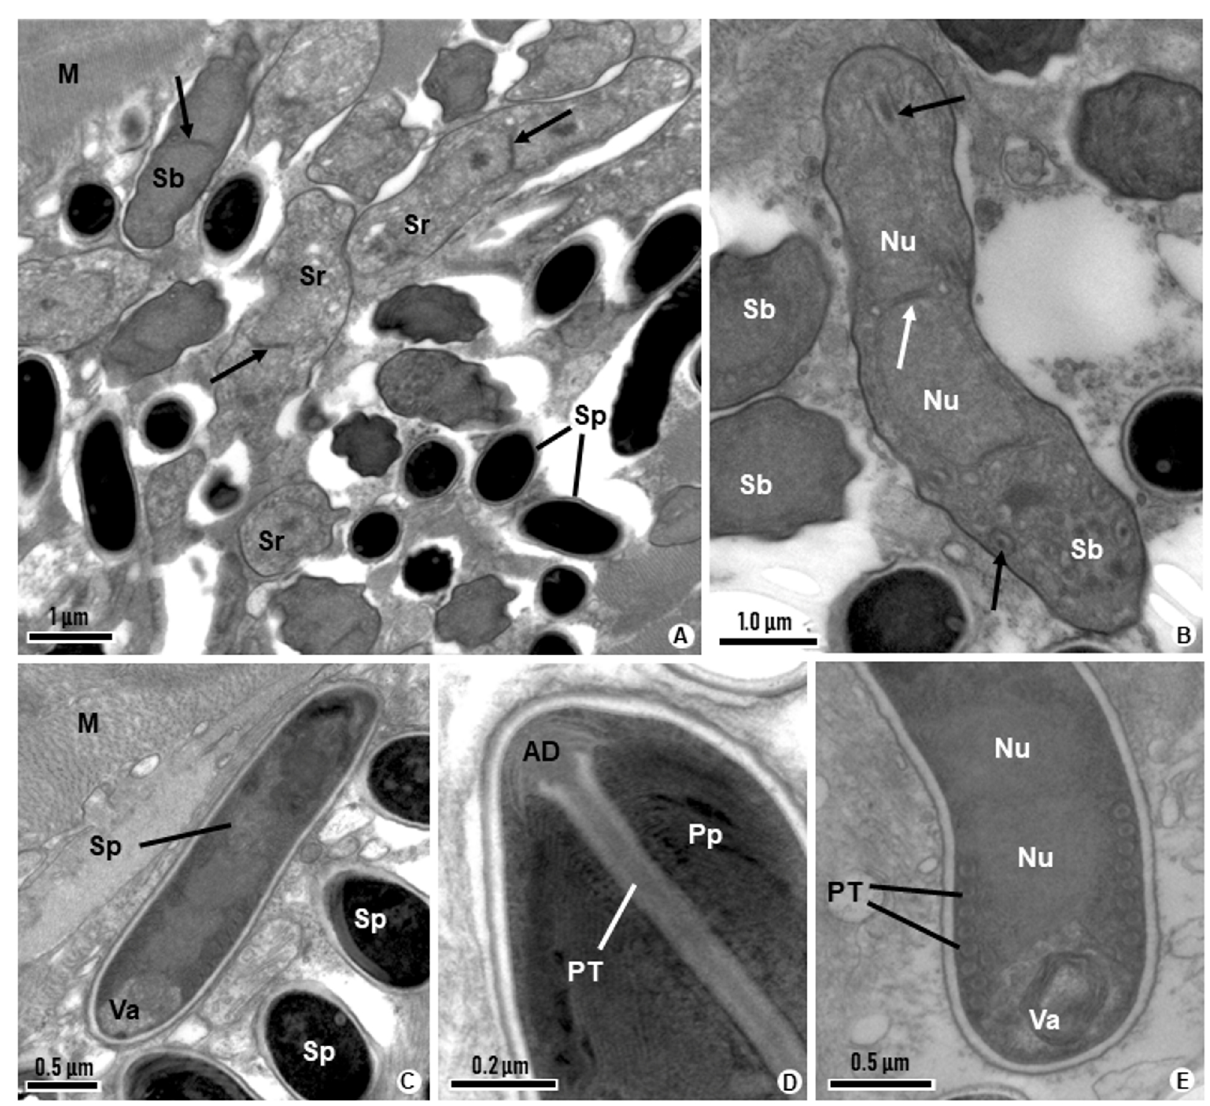
Figure 5. Ultrastructure of Myospora sp. ( A ) Different life cycle stages located among the muscles (M) showing the spores (Sp), surrounded by earlier intracellular stages, some displaying diplokaryons (arrows). Sr, sporonts. Sb, Sporoblasts. ( B ) Sporoblasts (Sb) sectioned at different levels. Diplokaryon is indicated by the white arrow, sections through the polar tube by the black arrow. ( C ) Sections through spores (Sp) showing posterior vacuole (Va) in contact with the muscle (M). ( D ) Longitudinal section of the apical region of the spore showing the anchoring disc (AD) and a manubrium part of the polar tube (PT), surrounded by the polaroplast (Pp). ( E ) Longitudinal section of the basal portion of the spore with two nuclei (Nu), the posterior vacuole (Va) and polar tube coils